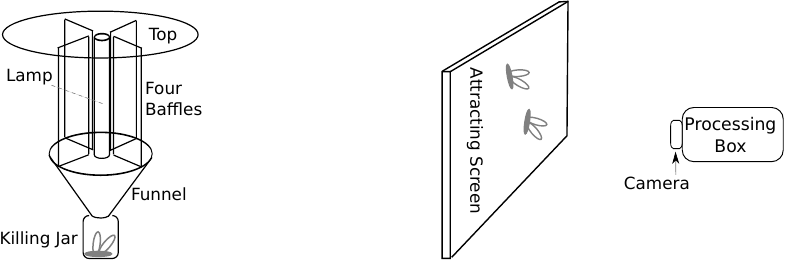
Figure 1. Evolution of light trap proven constructions from a classical schema of the Pennsylvania light trap ( left ) to typical construction of modern screen-camera light traps ( right